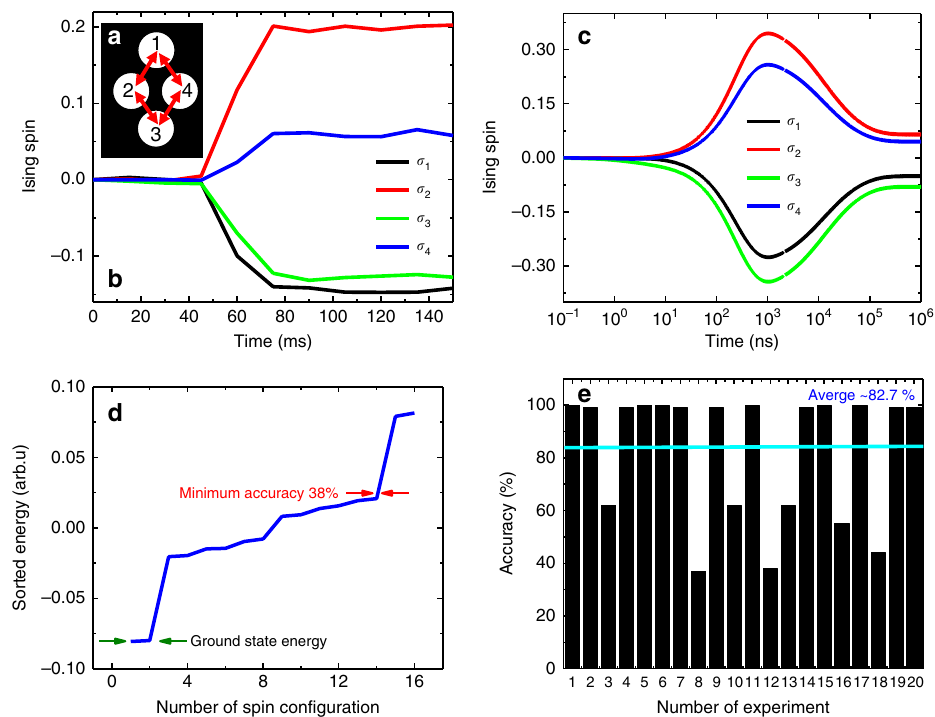
Fig. 9 Square lattice Ising Hamiltonian with N = 4. a Lattice connectivity design for the mutual coupling matrix. b Experimental Ising spin evolutions as the function of time. c Simulation result of the given Ising Hamiltonian. The CIM simulation found exact ground state. d Sorted Ising energy values for the 16 possible con fi gurations. e Accuracy versus number of experiment. The overall average accuracy of the CIM for the designed Ising Hamiltonian in a was 82.7%. The CIM found the ground state 6 times out of 20 times experiment and trapped twice to an accuracy of 38%